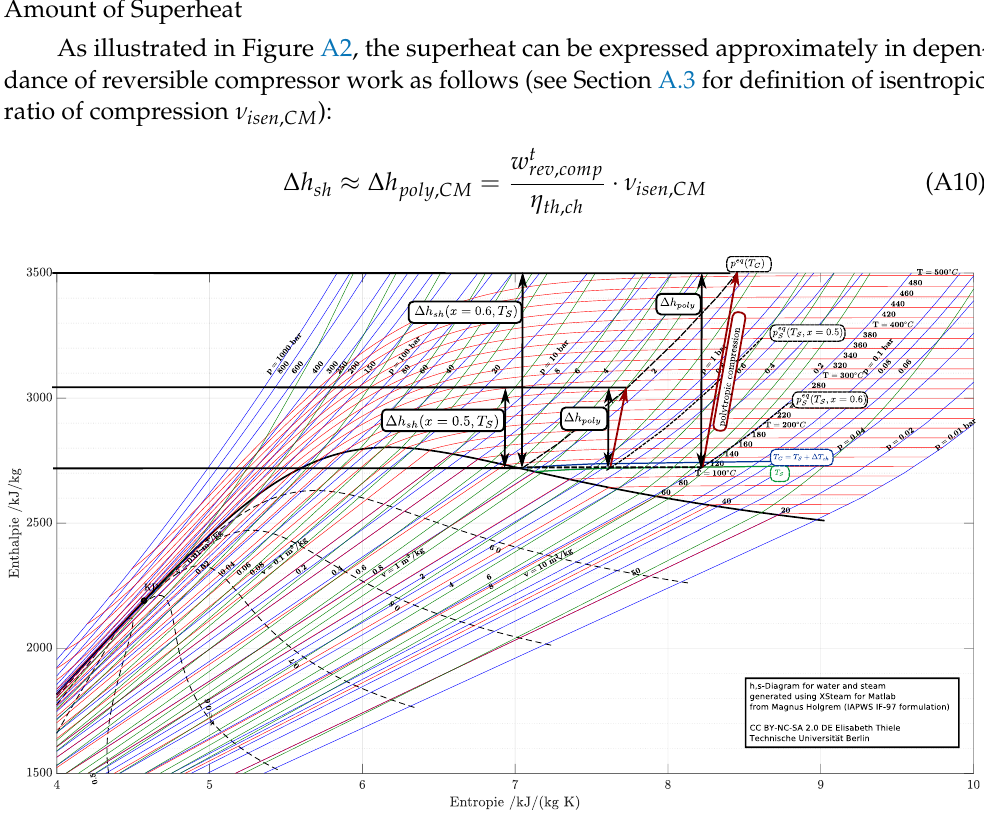
Figure A2. Illustration of superheat of water vapor after polytropic